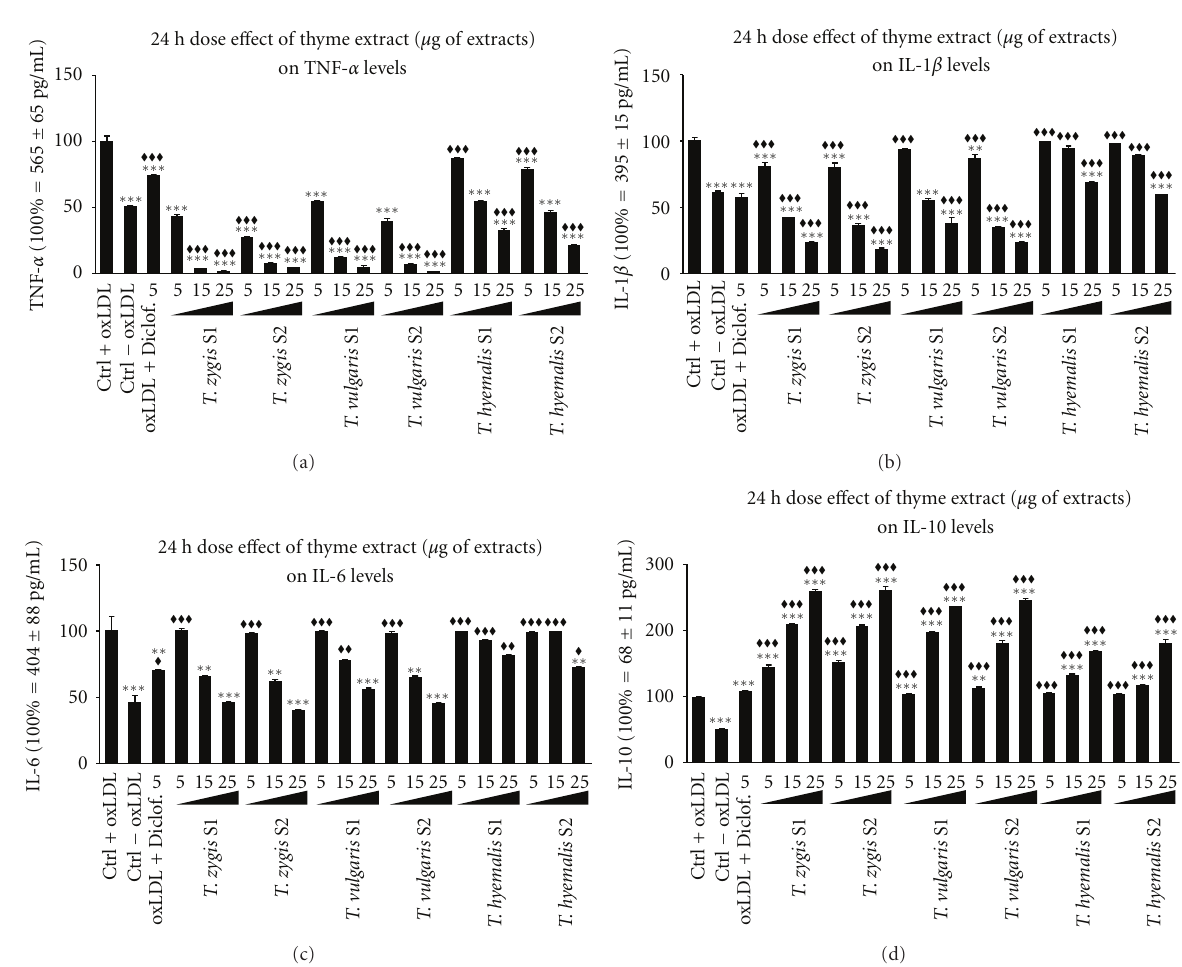
Figure 3: Dose e ff ect of 5, 15, and 25 μ g/mL of thyme extracts S1 and S2 from three di ff erent species ( Thymus vulgaris, Thymus zygis, and Thymus hyemalis ) on the production and secretion of TNF- α (a), IL-1 β (b), IL-6 (c), and IL-10 (d) on macrophage-THP-1 cells. Cells were di ff erentiated with (PMA) 100 ng/mL for 24 h and afterwards treated as described in Section 3 for 24 hours. Data represent means ± SEM calculated from six independent experiments with 3 replications for each treatment. Statistic Dunnett’s multiple comparison test versus Ctrl +oxLDL signification is represented by ∗ P values less than 0.05, significant; ∗∗ P values less than 0.01, very significant; and ∗∗∗ P values less than 0.001, extremely significant. One group was treated with a small concentration of diclofenac (5 μ g/mL) as positive standard control. Statistic Bonferroni multiple comparison test versus Ctrl − oxLDL signification is represented by (cid:3)(cid:3) P values less than 0.01, very significant and (cid:3)(cid:3)(cid:3) P values less than 0.001, extremely significant.